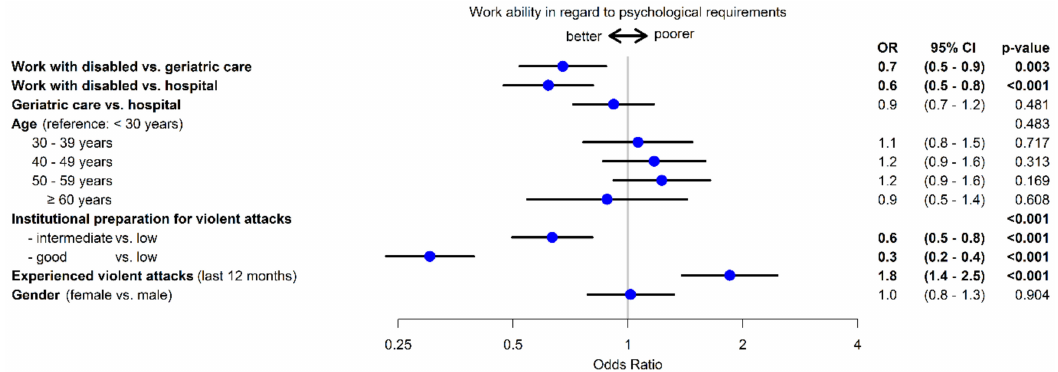
Figure 4. Risk factors for work ability with regard to the psychological demands of the